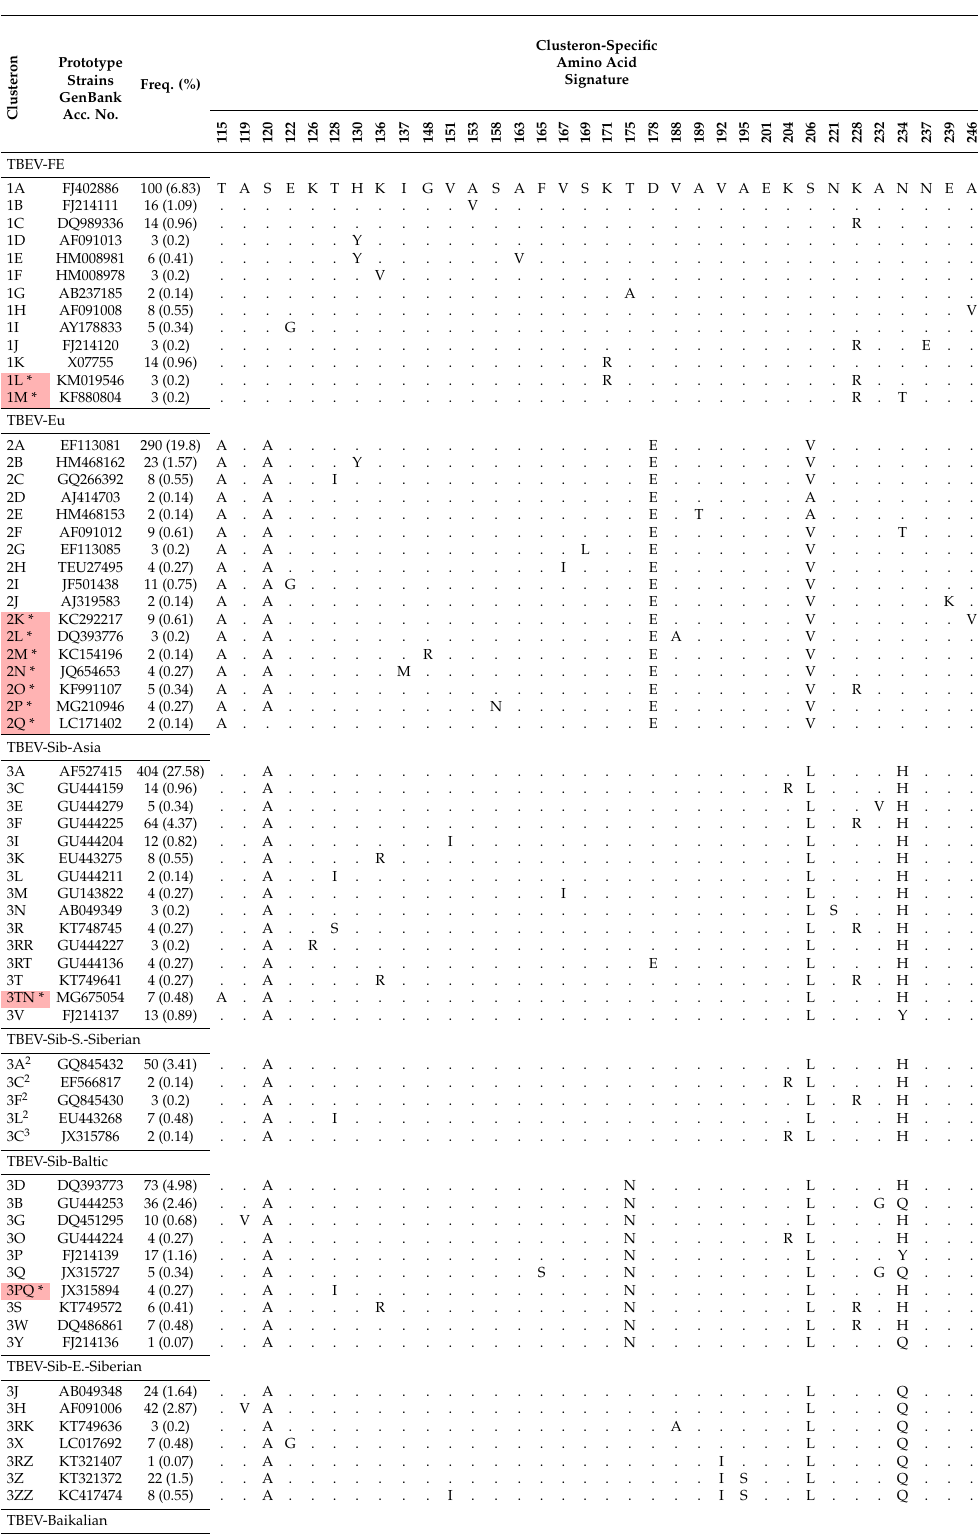
Table 1. Updated list of clusteron-specific amino acid signatures. Currently, there are 68 clusterons, which can be characterized via 34 amino acids. Note that positions 206 and 234 can represent the signature for subtype and lineage determination. The platform found eleven new clusterons (highlighted in